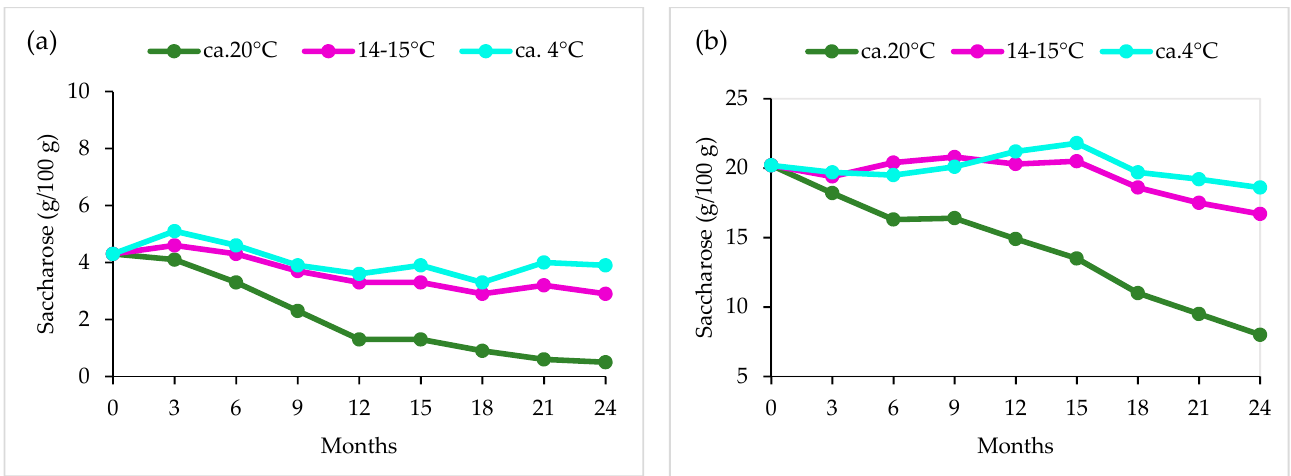
Figure 10. Changes of saccharose content in inverted saccharose syrup (Apiinvert) during storage ( a ) from 2012 and ( b ) from 2013.